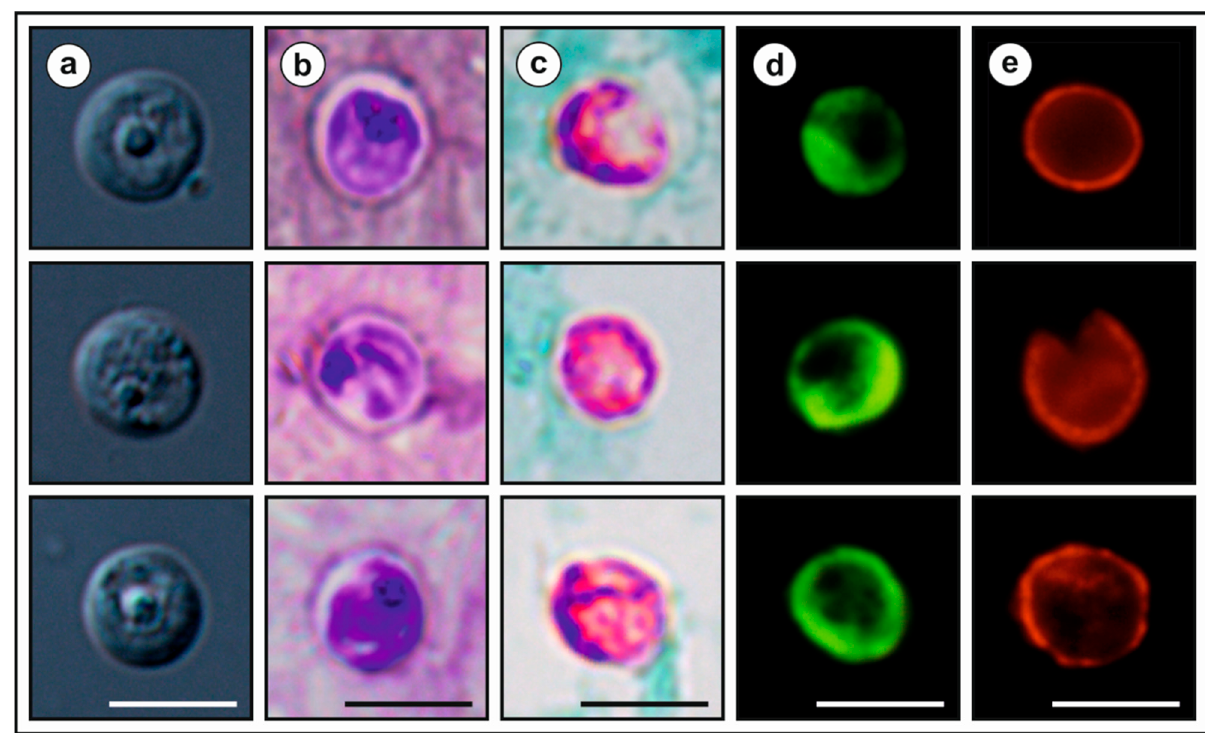
Figure 4. Infection intensity of Cryptosporidium sciurinum n. sp. in Eurasian red squirrels ( Sciurus vulgaris ) expressed as number of oocysts per gram of faeces (OPG). Data were collected from naturally infected Eurasian red squirrels. Animals aged 4–11 weeks old originated from rescue stations, and some of those animals were screened repeatedly (each animal is marked with a colour). The animal number (e.g., #45901) corresponds with the numbers in Table 1.